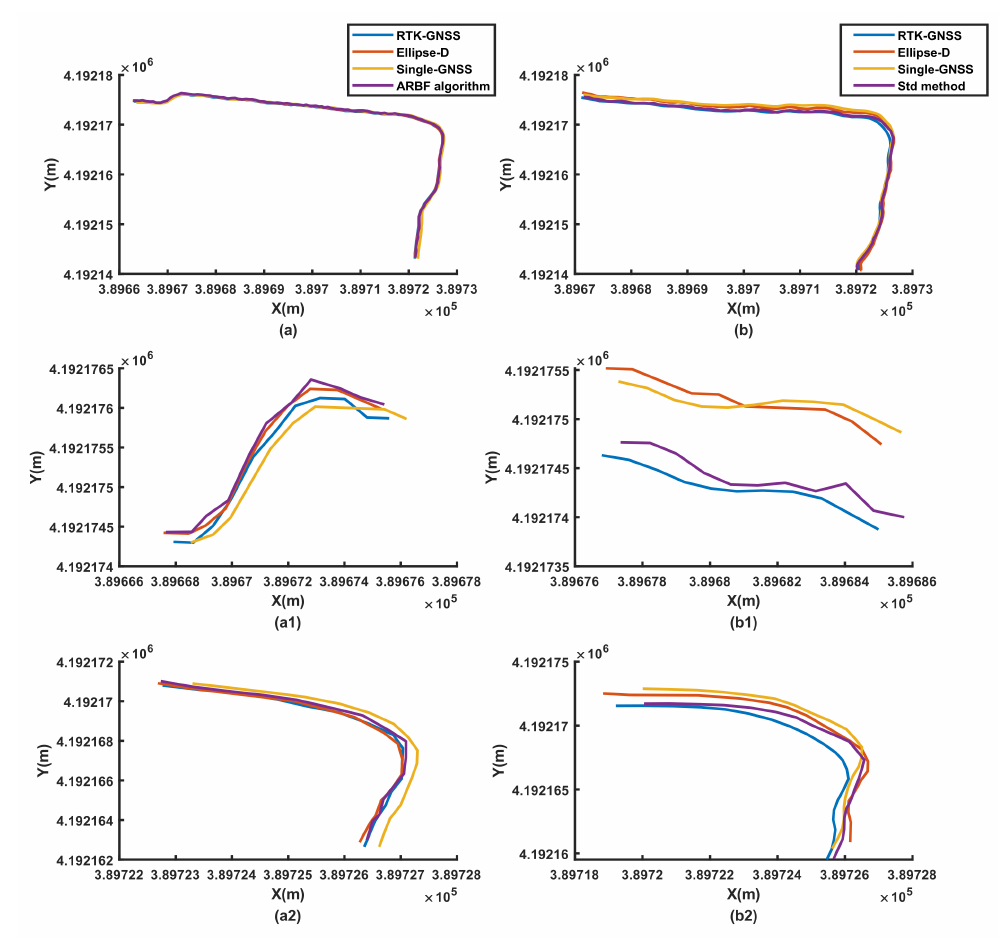
Figure 9. Experimental results from road: ( a ) position prediction results of ARBF algorithm; ( a1 , a2 ) local position data of ( a ); ( b ) position prediction results of the Std method; ( b1 , b2 ) local position data of ( b